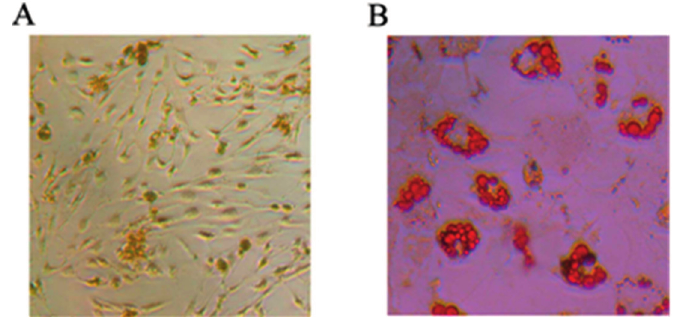
Figure 1. The potential of mesenchymal stem cells (MSCs) differentiating into osteoblasts and adipocytes. The Alizarin red staining of calcified nodules and Oil red staining were respectively applied to identify osteoblast differentiation ability ( A ) and adipogenic differentiation ability ( B ) of rat